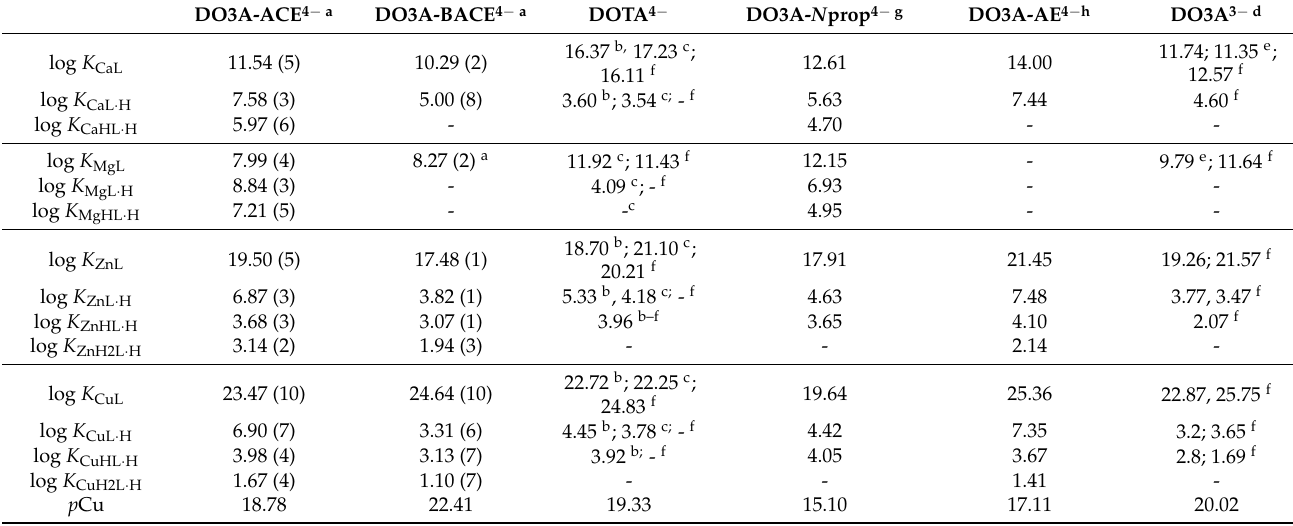
Table 2. Stability constants of DO3A-ACE 4 − , DO3A-BACE 4 − , DOTA 4 − , DO3A 3 − , and DO3A-Nprop 4 − with the essential alkaline earth (Mg 2+ and Ca 2+ ) and transition metal (Cu 2+ and Zn 2+ ) ions (25 ◦